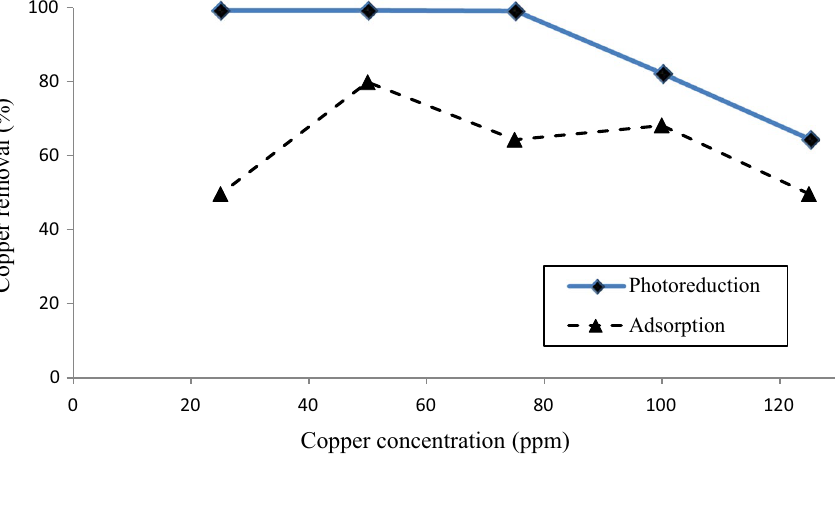
Fig. 6 Percentage of photo- reduction against the mass ratio of CuFeO 2 –ZnO in the hetero-